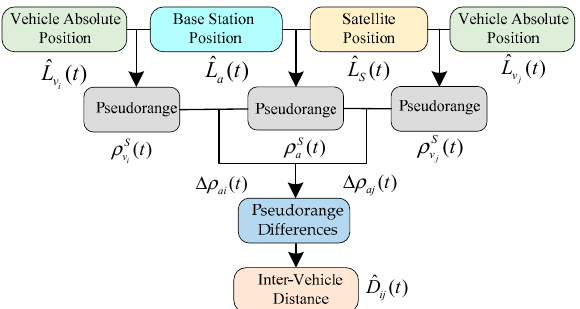
Figure 4. Flowchart of Pseudorange Differencing (PD)-based IVD estimation method.